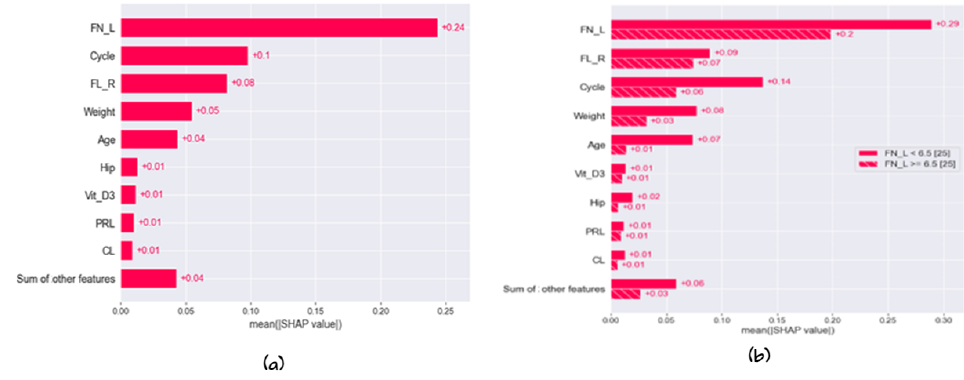
Figure 10. Global explainability of the developed model: ( a ) bar plot ( b ) Cohort plot.